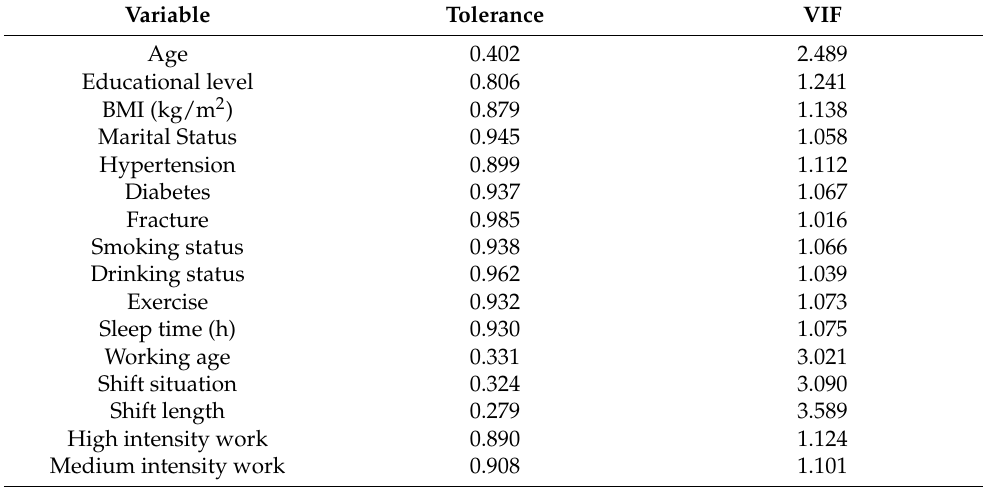
Table 5. Multicollinearity of independent